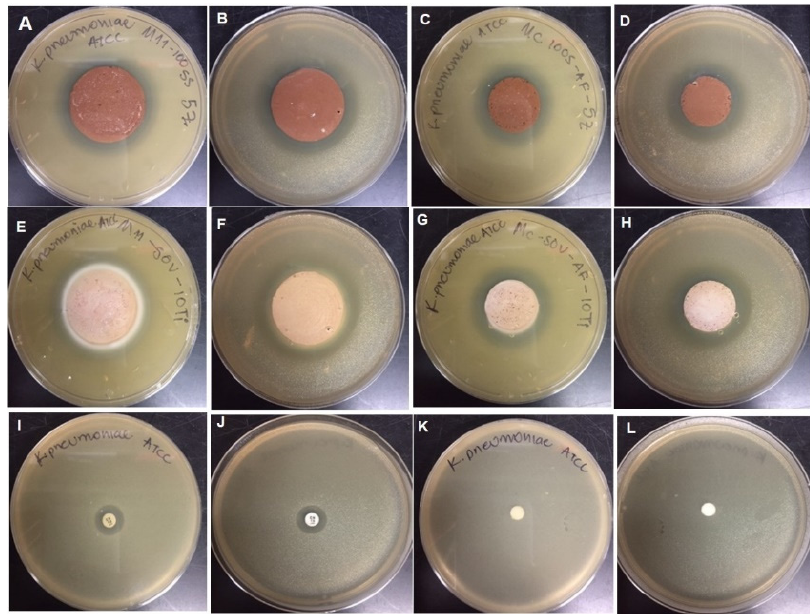
Figure 10. Images corresponding to the agar of K. pneumonia for different mixtures and the control. Front and rear views are presented, respectively. ( A , B ) paste 100SS-5Z, ( C , D ) mortar 100SS-AF-5Z-G, ( E , F ) paste 50SS:50G-10Ti, ( G , H ) mortar 50SS:50G-AF-10Ti-G, ( I , J ) Sensi-disc control of gentamicin, and ( K , L ) Sensi-disc control with no inhibition. Table 7. Inhibition halos obtained in the culture of the ATCC strains of K. pneumoniae and P. aeru- ginosa with the evaluated materials and controls. Type